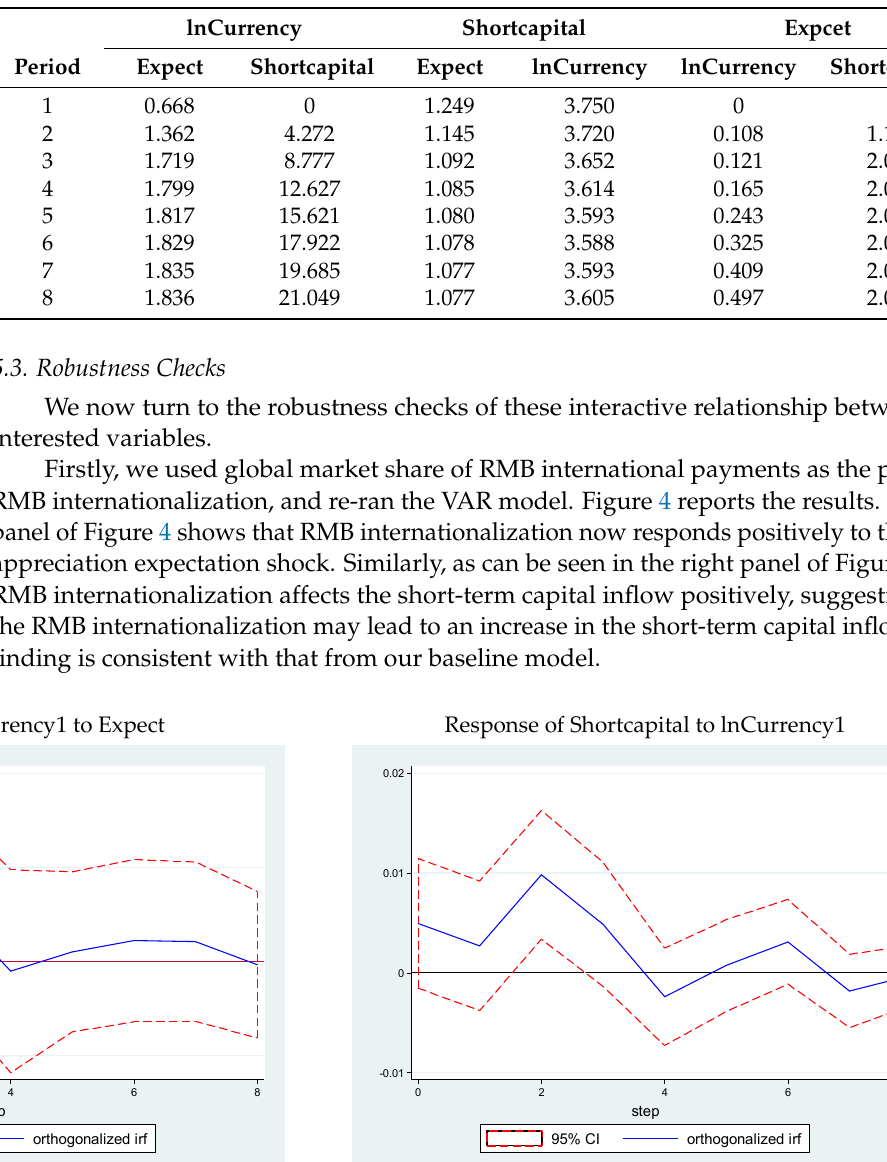
Table 4. Variance decomposition of three variables (in percentage).